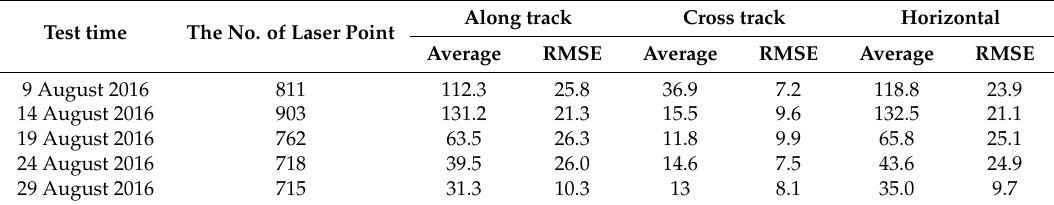
Table 3. Prediction location accuracy condition verified by the post-processed data.